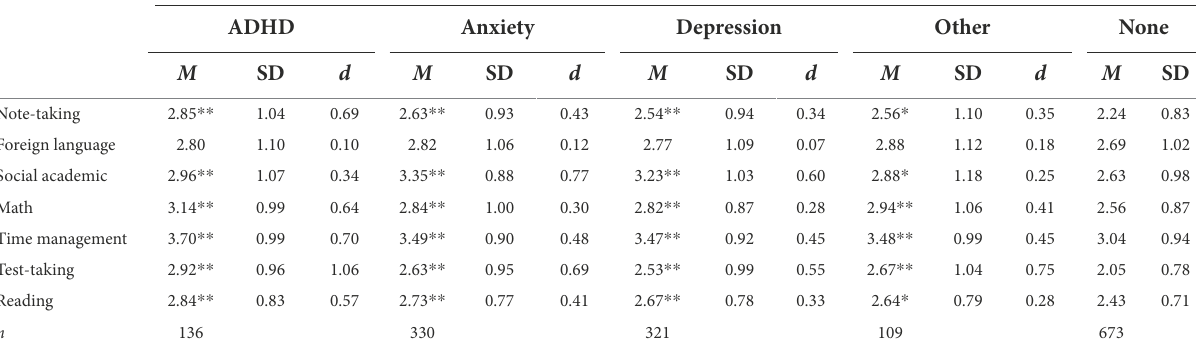
TABLE 7 Average AIM composite scores as a function of recent mental health treatment. Domain